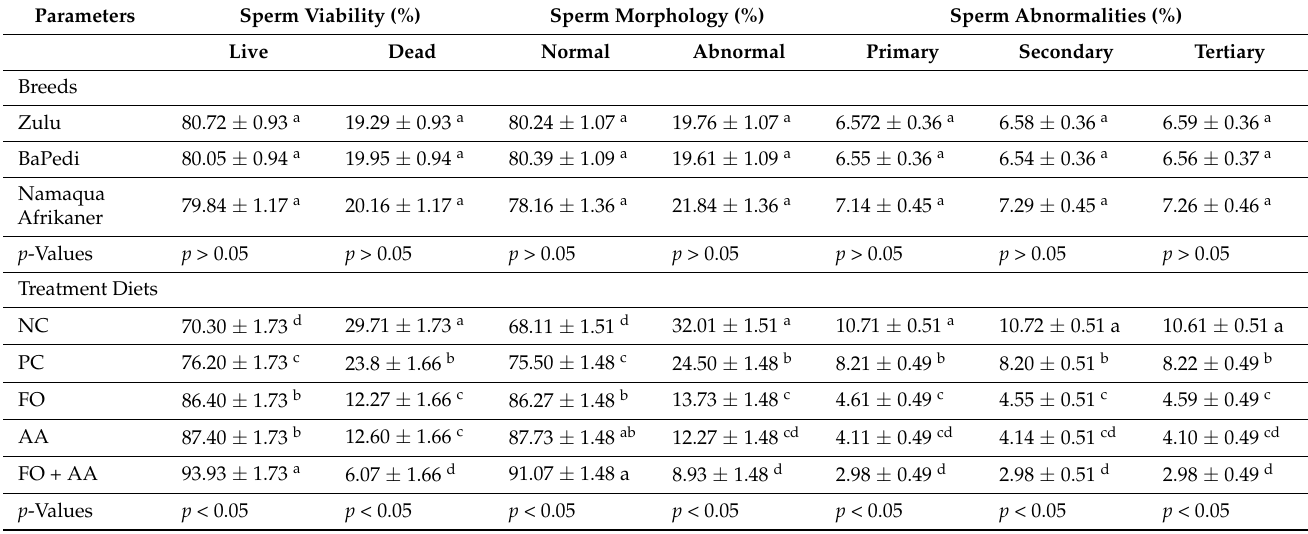
Table 5. Influence of breed and dietary treatments on sperm viability, morphology, and plasma membrane